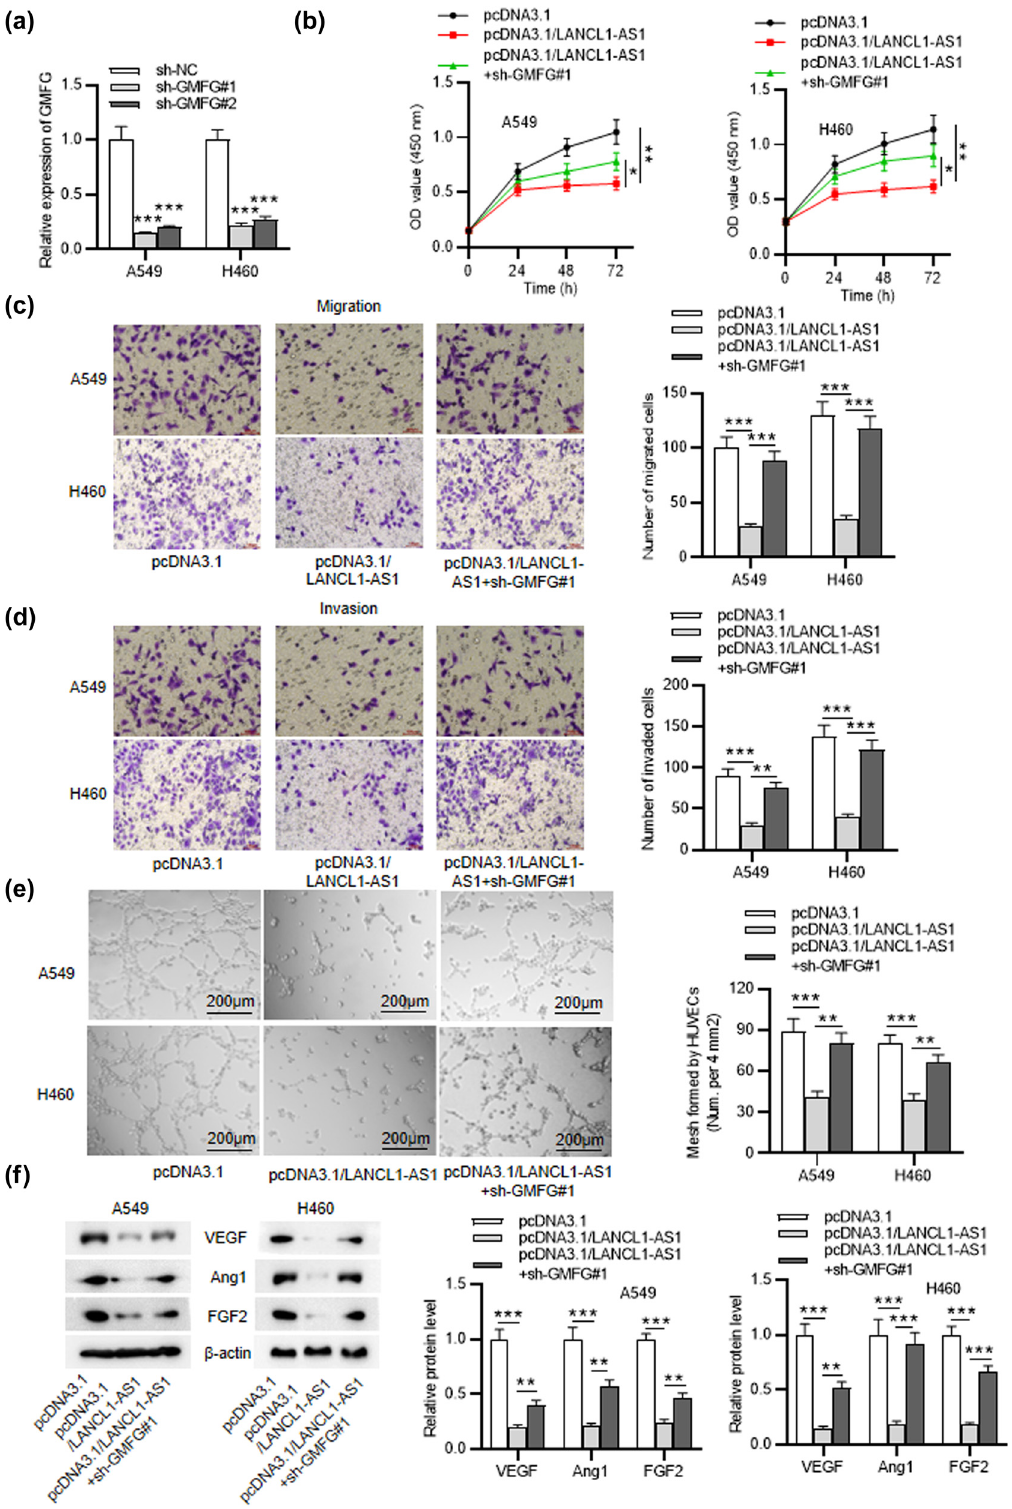
Figure 5: GMFG silencing rescues LANCL1 - AS1 overexpression - mediated inhibitory e ff ect on NSCLC cellular activities. ( a ) RT - qPCR for evaluating the transfection e ffi ciency of sh - GMFG#1/2 in A549 and H460 cells. ( b ) CCK - 8 assay for assessing viabilities of A549 and H460 cells treated with pcDNA3.1, pcDNA3.1/LANCL1 - AS1, or pcDNA3.1/LANCL1 - AS1 + sh - GMFG#1. ( c and d ) Transwell assays for analyzing the migration and invasiveness of NSCLC cells with above treatment. ( e ) Tube formation assay for detecting the mesh formed by HUVECs. ( f ) Western blotting for evaluating angiogenesis - related proteinlevels inNSCLC cells with above transfection. * p < 0.05, ** p < 0.01, *** p <